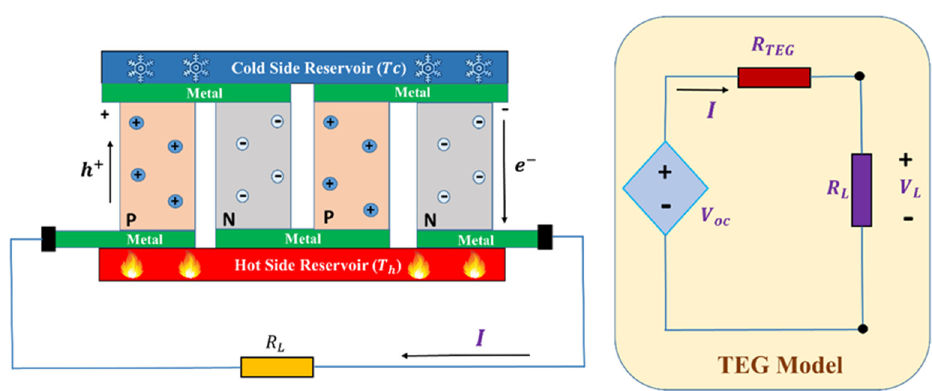
Figure 1. TEG system with MPPT.